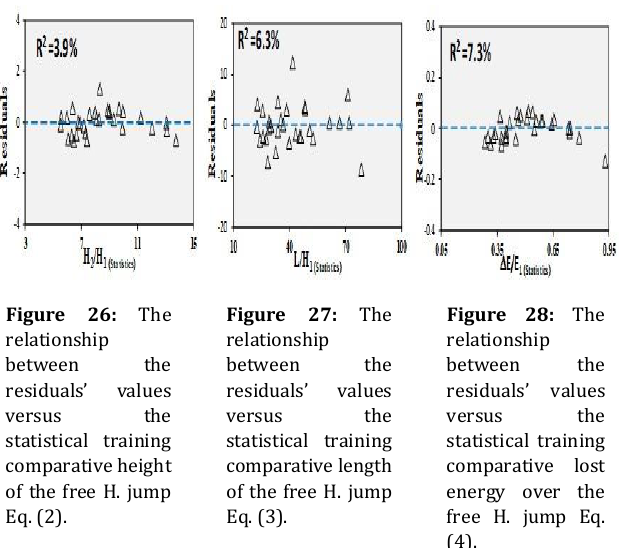
Figure 23: The relationship between the training values of the comparative height of the free H. jump Eq. (2) and the experimental measurements.